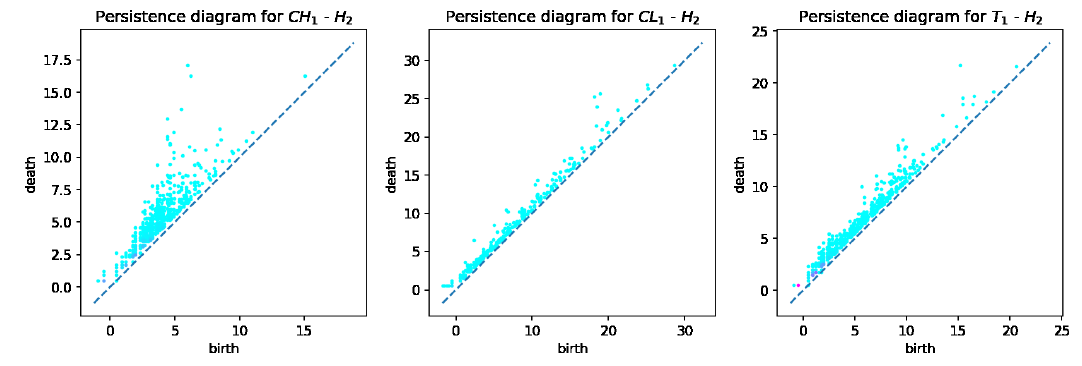
Figure 4. H 2 persistent diagrams for CH, CL, and T samples.